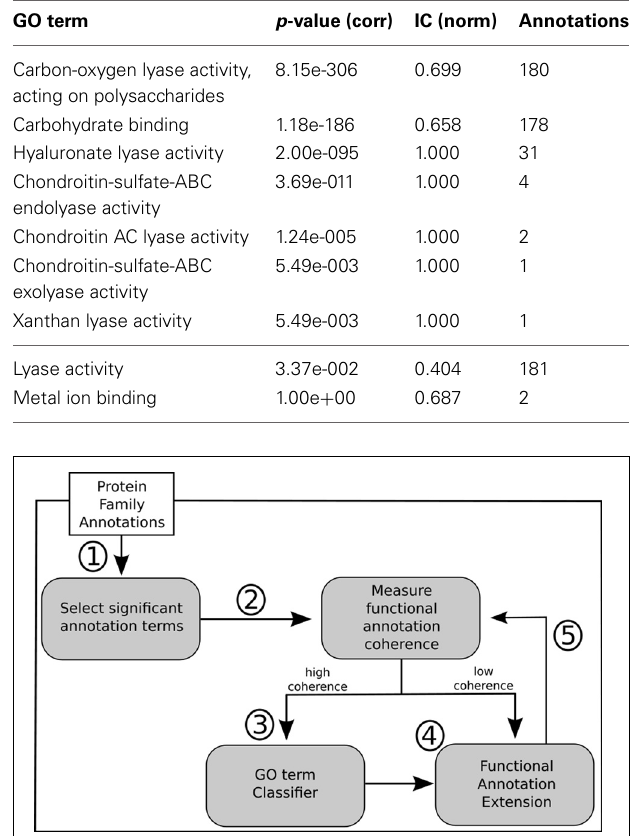
Table 3 | GO term enrichment for CAZy family PL8 with Benjamini-Yekuteli corrected p -values, normalized IC and number of annotations.